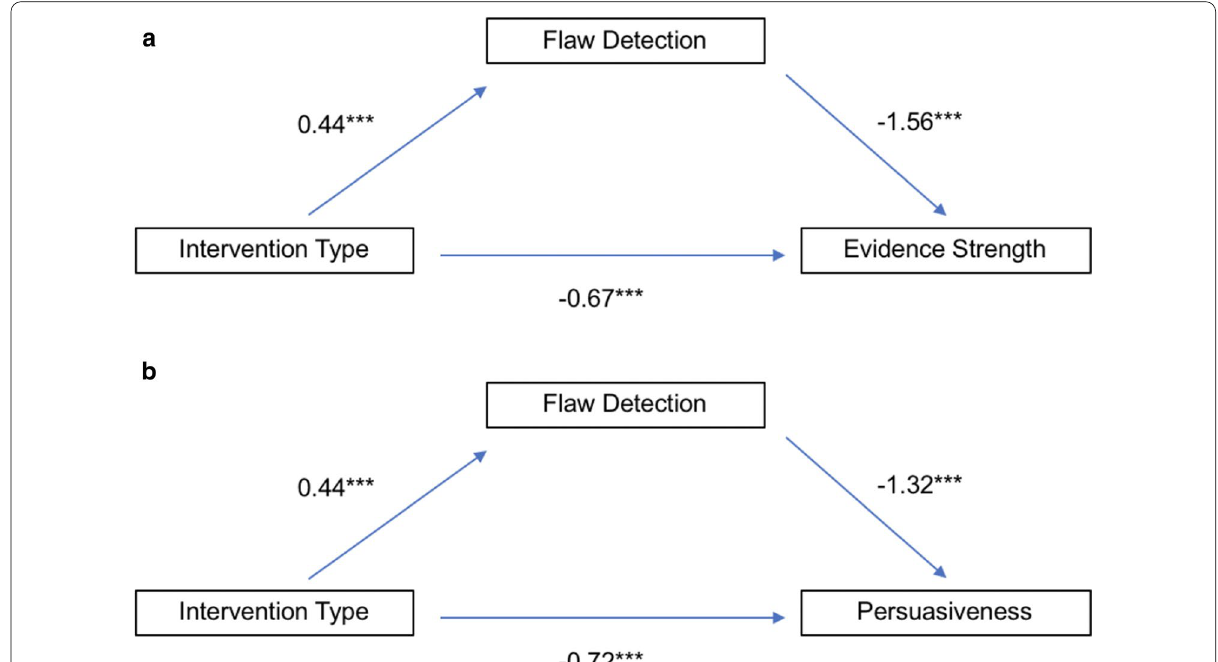
Fig. 3 Mediation analysis showing direct and indirect effects (via detection rates of study flaws) of intervention type on evidence strength ratings ( a ) and on persuasiveness ratings ( b )